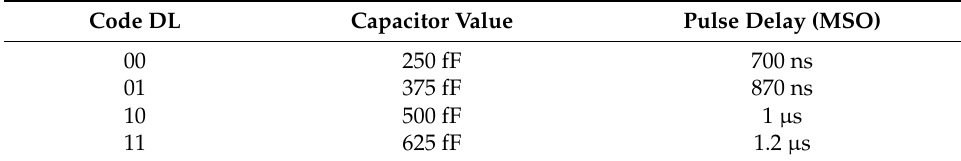
Table 4. Programming of the monostable